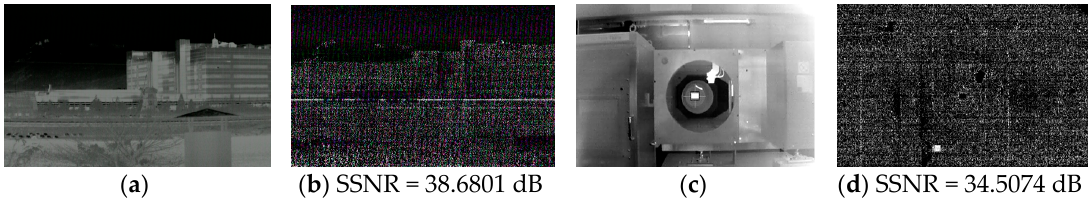
(SSNR). Here, ( a , c ) are original images; ( b ) shows noise components containing horizontal line flickering